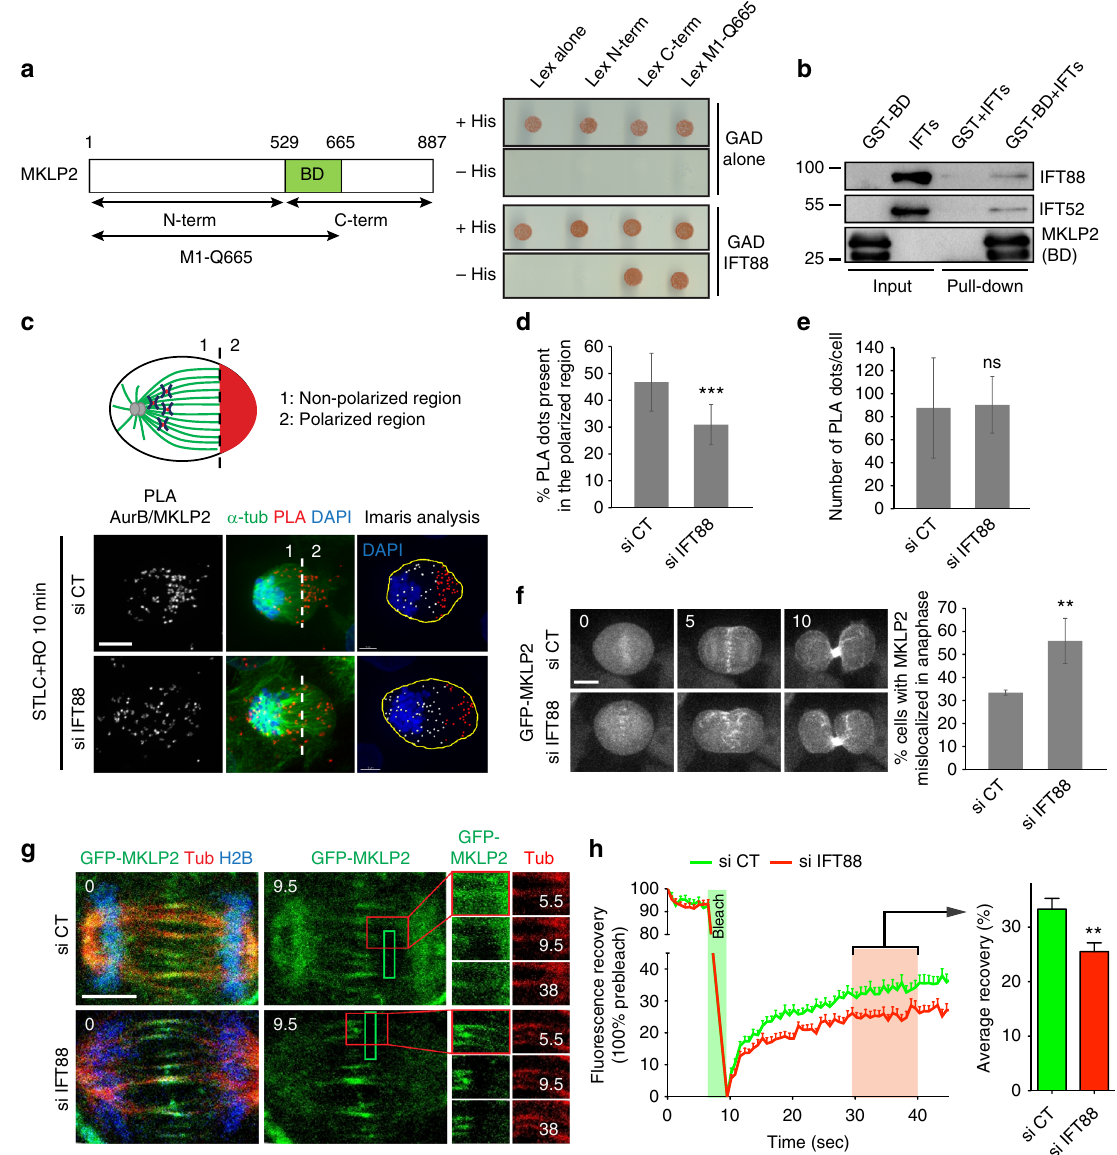
Fig. 3 IFT88 interacts with MKLP2 and is required for a timely and uniform relocalization of the Aurora B/MKLP2 complex to the central spindle. a Speci fi c interaction between IFT88 and MKLP2 in a yeast two-hybrid assay unraveling IFT88-binding domain (BD). Schematics of MKLP2 domains (left). S. cerevisiae reporter strain expressing the indicated GAD- and Lex- fusion proteins are grown on selective medium with or without Histidine (right). b Recombinant GST and GST-tagged MKLP2-BD bound to Glutathione sepharose beads were incubated with recombinant IFTs (IFT88-70-52-46). Interacting proteins were analyzed by western blots, unraveling an interaction between IFTs and MKLP2 (BD). c Schematic showing a monopolar cytokinetic cell divided into two regions: (1) non-polarized region and (2) polarized region where cytokinetic regulators accumulate. PLA between MKLP2 and Aurora B in monopolar cytokinetic LLC-PK1 cells showing the localization of the Aurora B/MKLP2 complex. Maximum projections are shown (left and middle panels). Detection of PLA dots in cells (yellow line) was done using Imaris (right panel). White objects, PLA dots in the non-polarized region (1). Red objects, PLA dots in the polarized region (2). DAPI staining (blue) is shown. d , e Percentage of PLA dots in the polarized region ( d ) and total number of PLA dots per cell ( e ). n > 17 cells per condition. Mean+ / − s.d. ns: not signi fi cant and *** P < 0.001 compared to control ( t test). f Time-lapse of mitotic HeLa Kyoto cells expressing GFP-MKLP2 and transfected with control or IFT88 siRNA. Time (min). Percentage of cells with defects in GFP-MKLP2 localization during anaphase. n > 40 cells. Four experiments. Mean+ / − s.d. ** P < 0.01 compared to control ( t test). g FRAP analysis of Hela Kyoto GFP- MKLP2 cells in anaphase. Green boxes indicate the photobleaching zone, red boxes are magni fi ed in the insets (right). Time of recovery is indicated in seconds. Inset 5.5 s, image before photobleaching. Inset 9.5 s, image after photobleaching. h Quanti fi cation of FRAP experiments. Green line, control. Red line, IFT88-depleted condition. Graph (right) shows the average recovery value measured between 30 and 40 s of recovery for individual cells. n = 39 cells for the control condition and n = 47 cells for the IFT88-depleted condition. Two experiments. Mean+ s.e.m. ** P < 0.01 compared to control ( t test). Time of recovery (seconds). Scale bars: 10 μ m for main images, 3 μ m for insets unless otherwise